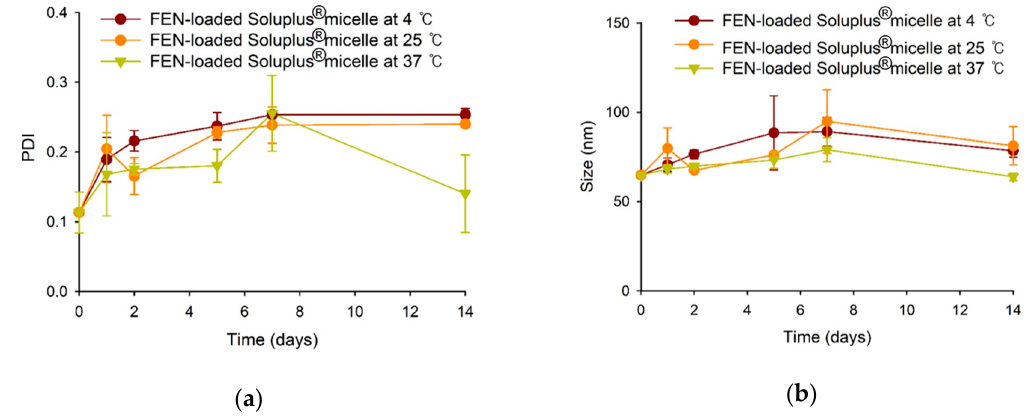
® micelles at various temperature.